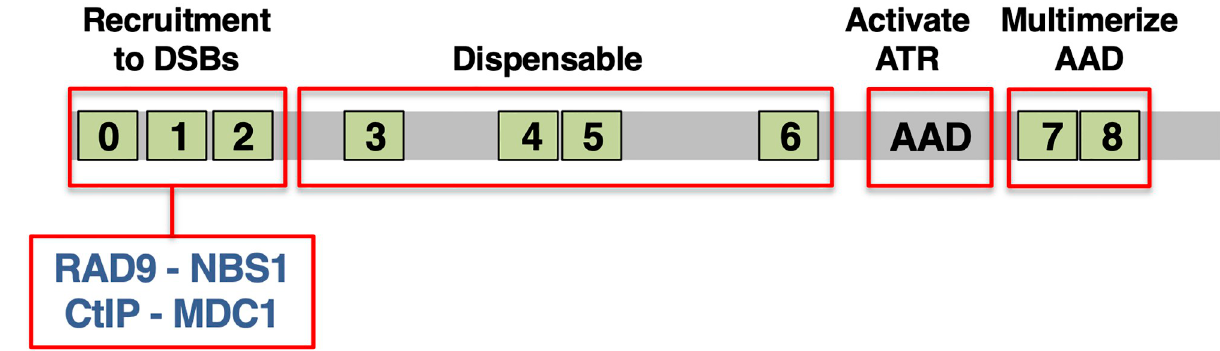
Fig 1. Functional domains and binding partners of TOPBP1. Please see text for